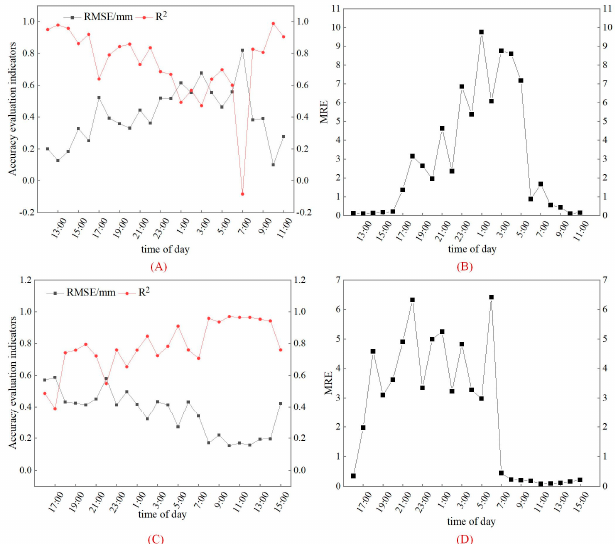
Figure 11. Comparison of accuracy of SVR inversion of OFT at di ff erent times: ( A ) RMSE and R 2 in summer; ( B ) MRE in summer; ( C ) RMSE and R 2 in autumn; ( D ) MRE in